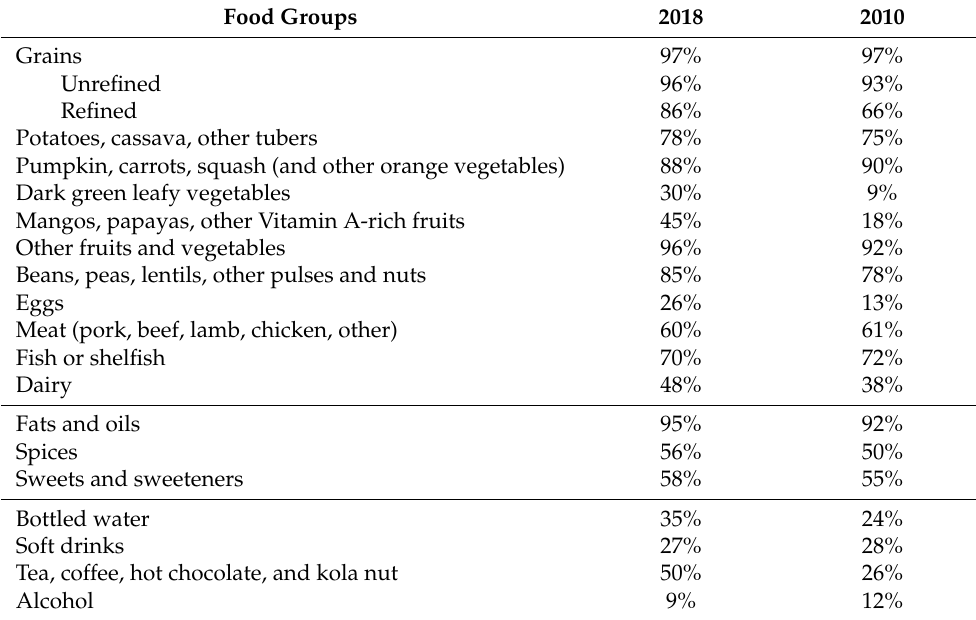
Table 2. Food groups eaten by Nigerian households in in the 7 days prior to the surveys in 2018 and 2010